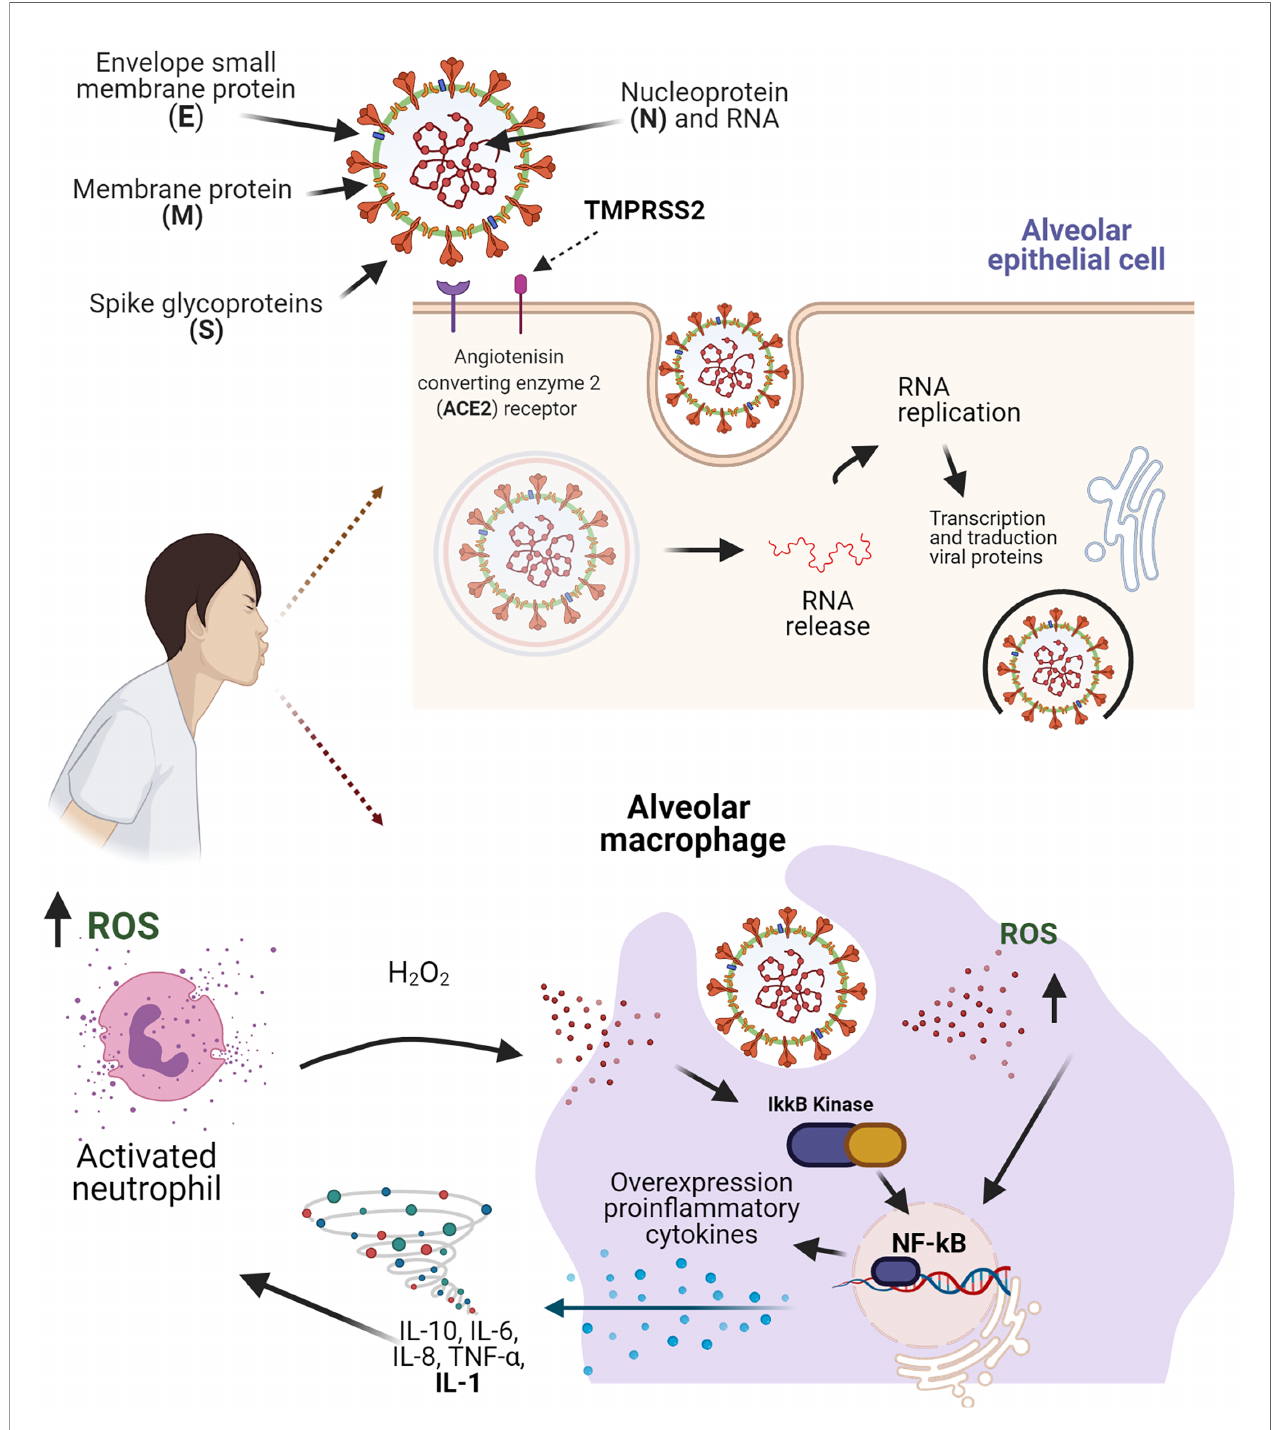
FIGURE 1 | Structure of the SARS-CoV-2 virus and molecular mechanisms in the in fl ammation process and oxidative stress. The binding of the S protein to a receptor ACER2 and the co-receptor TMPRSS2, allows the SARS-CoV-2 entry the alveolar epithelial cell. The recognition of SARS-CoV-2 in the macrophages, leads the accumulation of ROS and facilitates the activation of the NF-kB pathway, which results in an expression of pro-in fl ammatory cytokines that promote neutrophil activation. Figure created with BioRender,